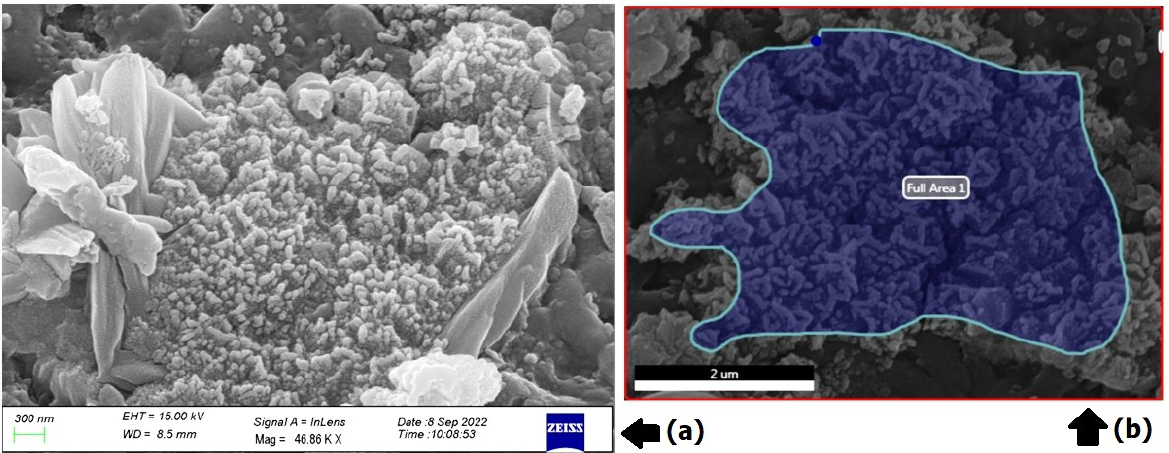
Figure 5. SEM images of Cu-Mn bimetallic nanoparticles at lower ( a ) and higher ( b ) magnification .